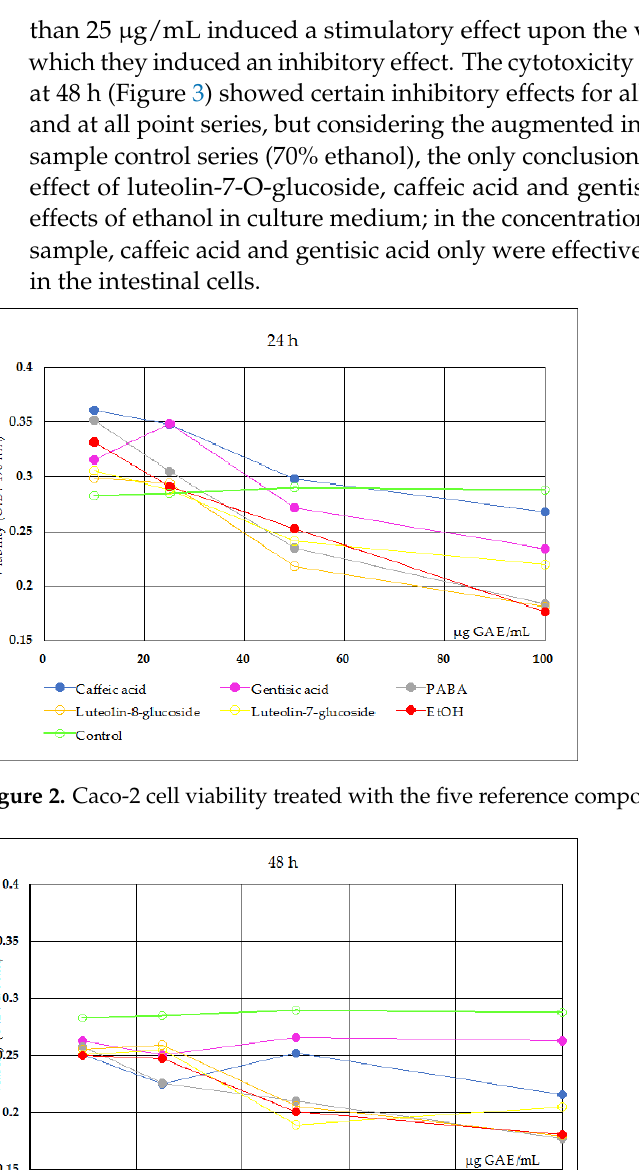
Figure 3. Caco-2 cell viability treated with the five reference compounds (phenolics), at 48 h